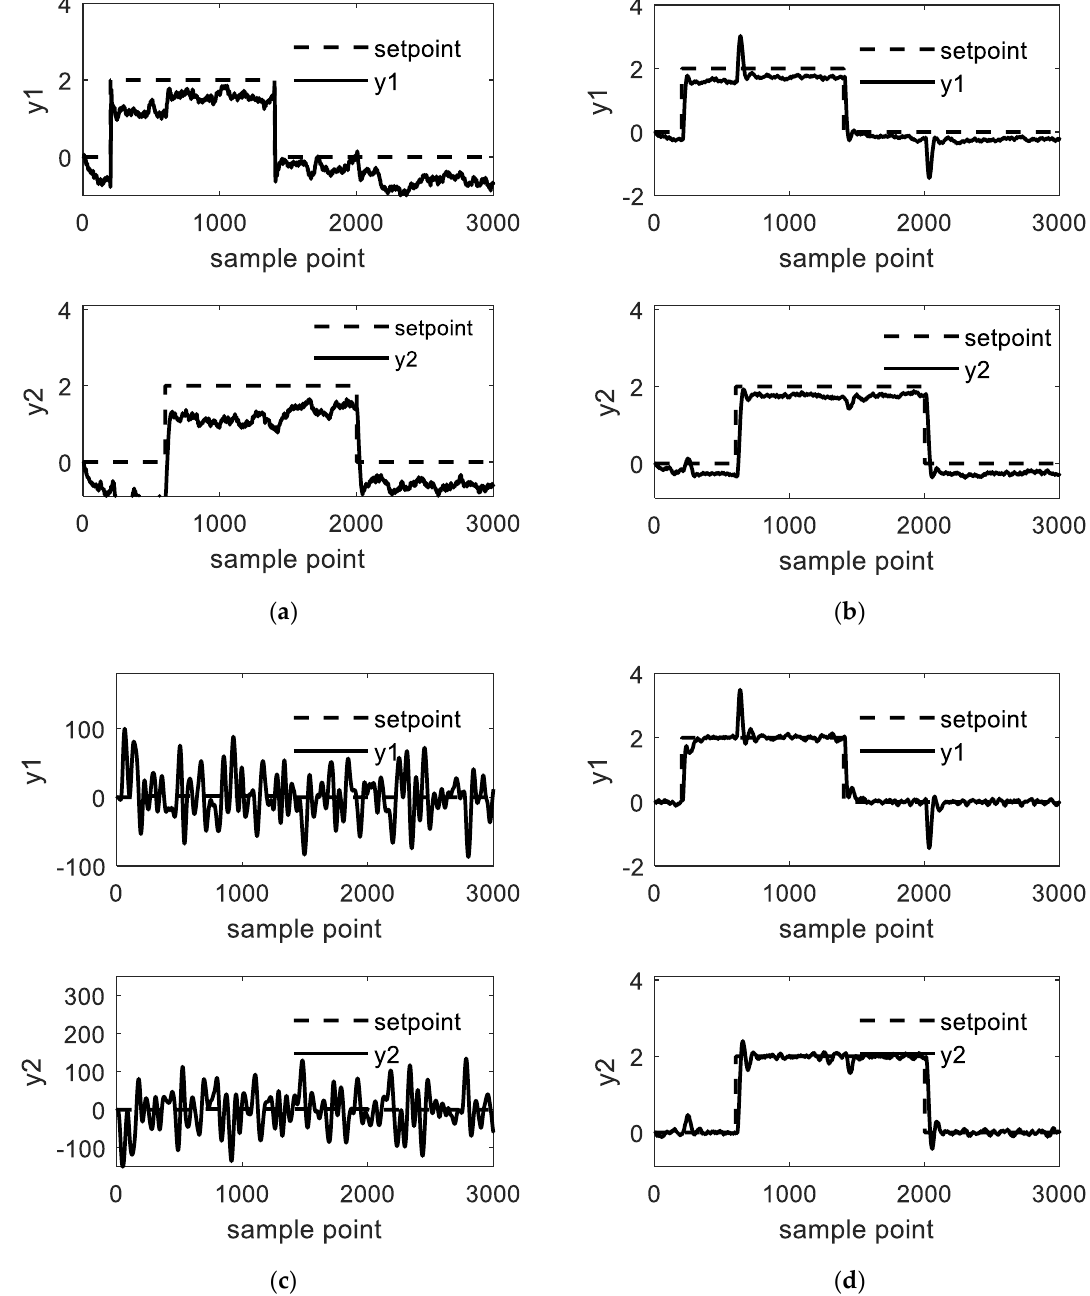
Figure 8 . The response of system with disturbance ( a ) SMPC; ( b ) SMDP; ( c ) OSMDP1; ( d ) OSMDP2.